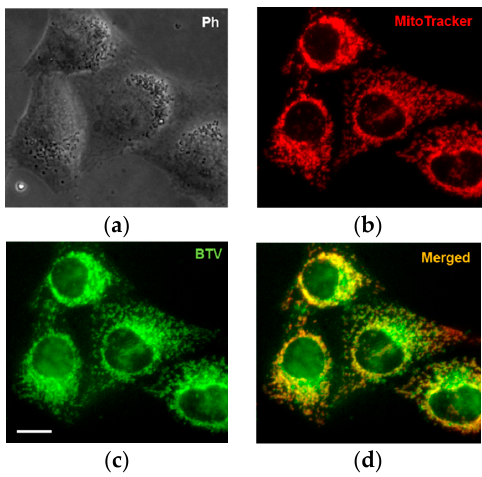
Figure 4. Fluorescence microscopic images of BTV (1 µM) in HeLa cells with 0.5 µM MitoTracker. DeepRed. Images were taken with a 40× objective. Scale bar represents 20 µm. ( a ) Phase contrast; ( b ) MitoTracker DeepRed; ( c ) BTV ; ( d ) Merged of MitoTracker DeepRed and BTV .